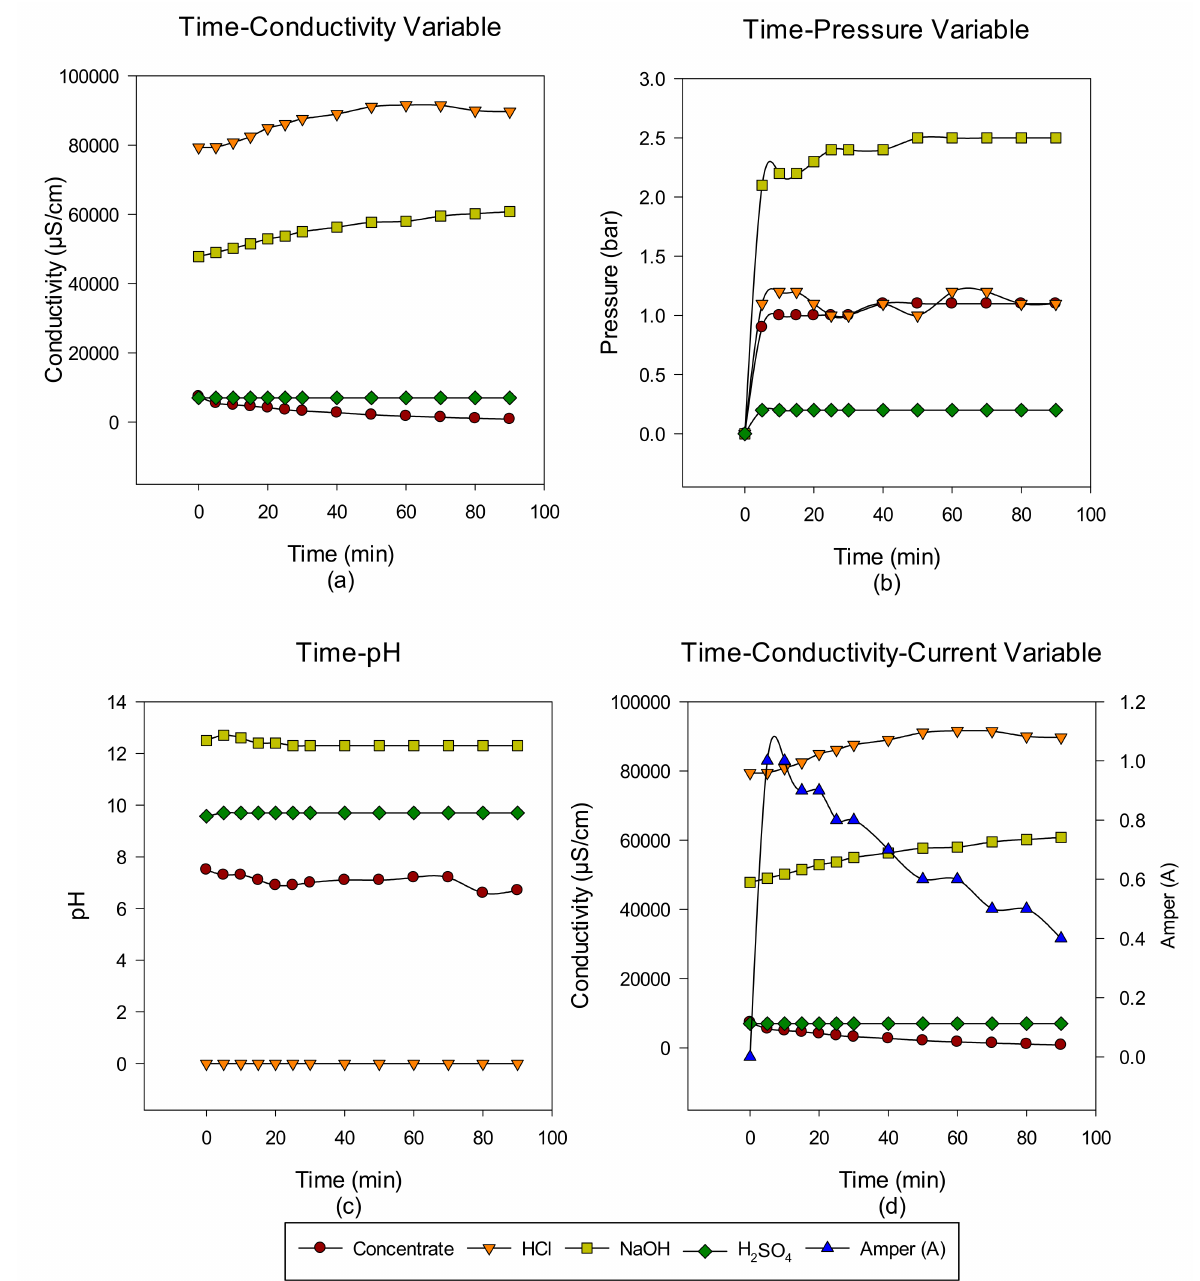
Figure 8. Between 0 and 90 min, NaCl–NaOH–HCl–Na 2 SO 4 ( a ) conductivity, ( b ) pressure, ( c ) pH, and ( d ) conductivity and ampere